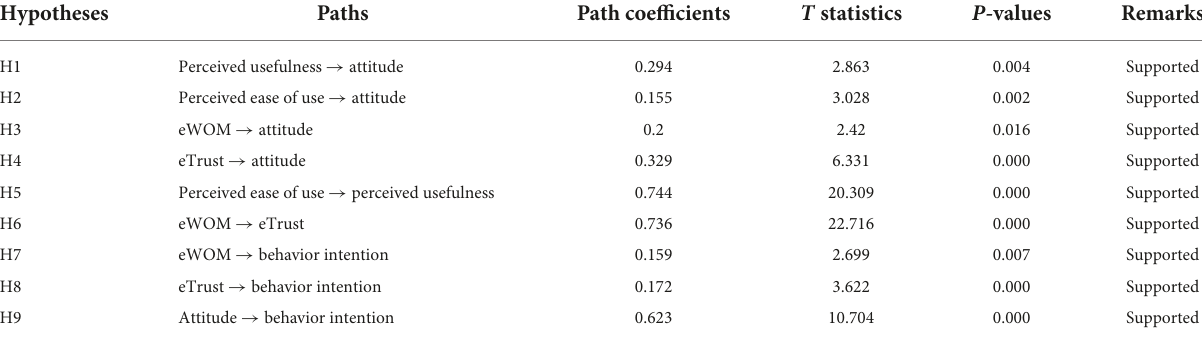
TABLE 5 Path coefficients and test results.